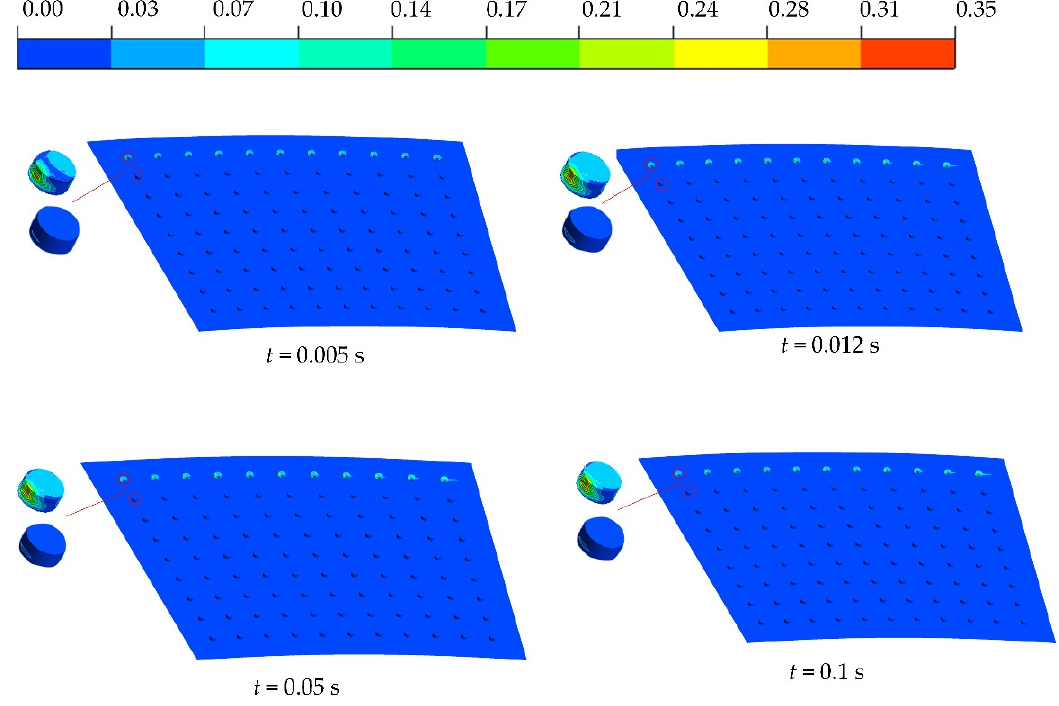
Figure 10. Cavitation morphology evolution when texture rate is 3.205%.